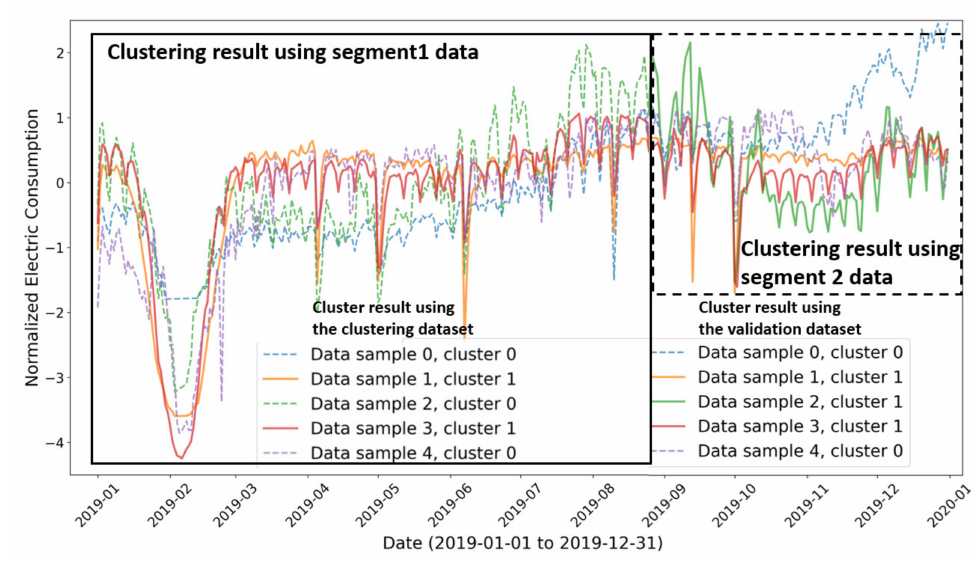
Figure 4. An example of two different clustering results obtained by using different segmentations of the same time-series dataset (hypothetical result with only five samples for demonstration